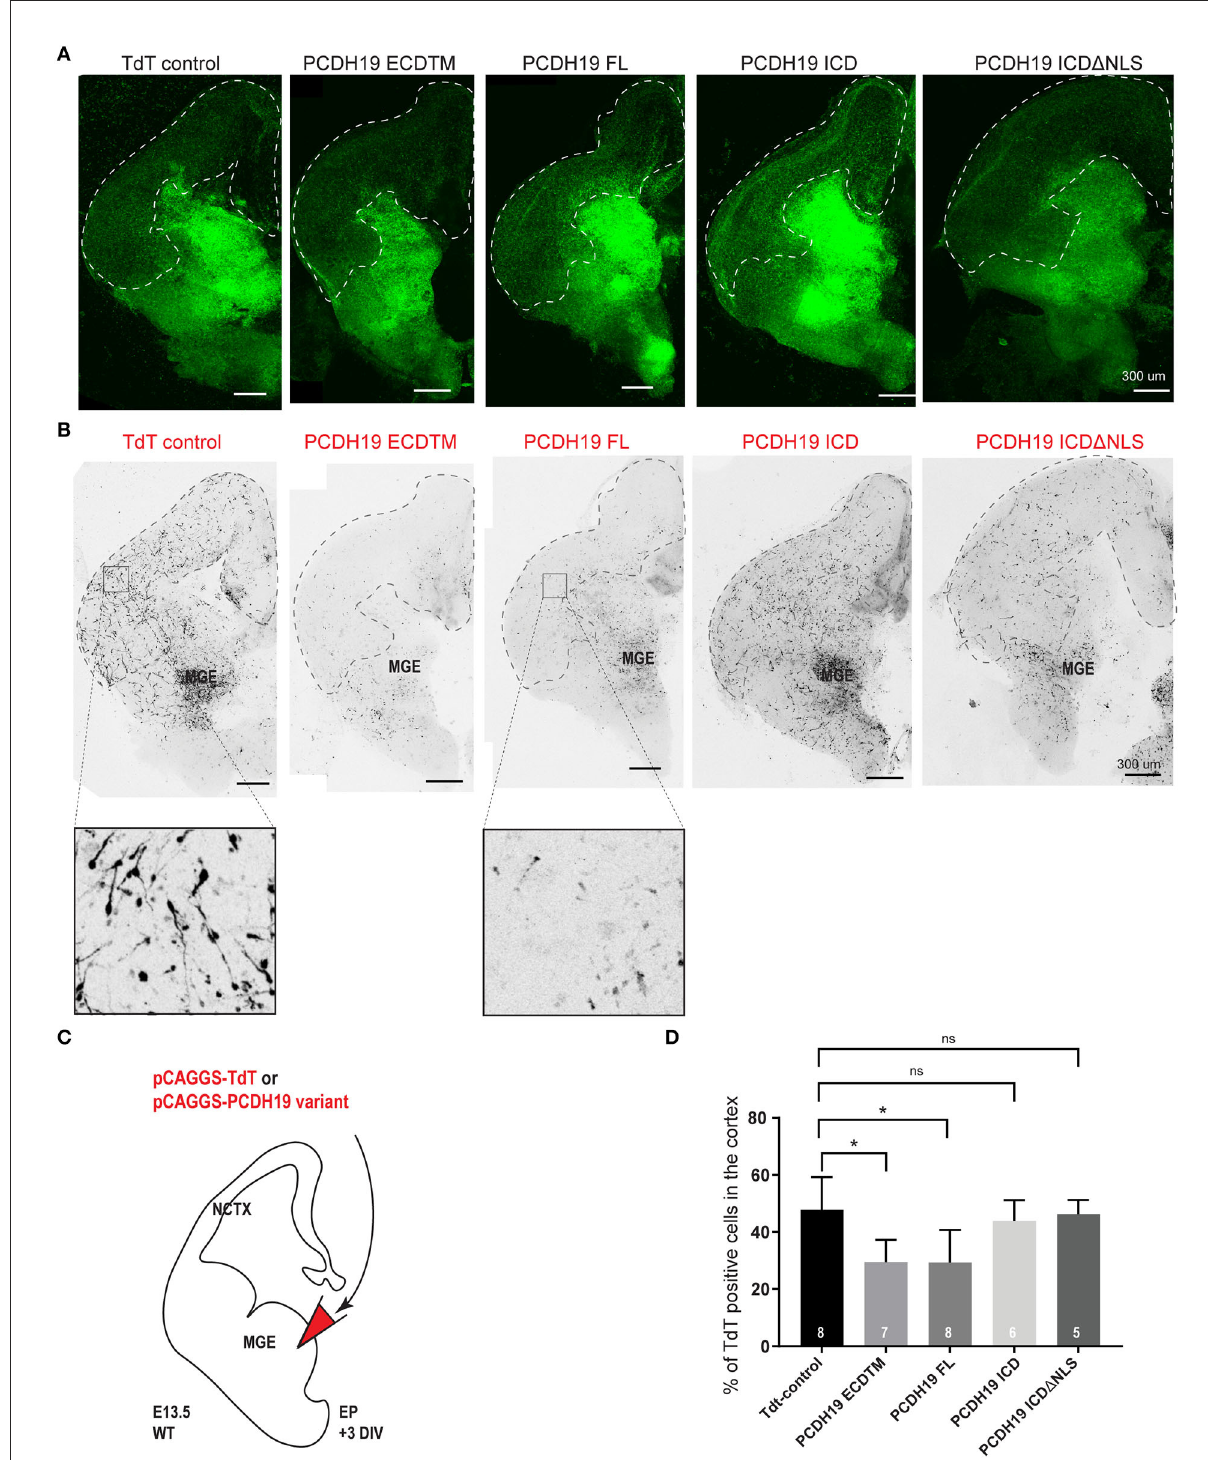
FIGURE3 PCDH19 extracellular domain misexpression significantly decreases cortical IN migration. (A) 72-h post electroporation taken Z-stack example images of brain slices of TdT control and various PCDH19 overexpression constructs for the Dlx5/6-CRE-IRES-eGFP fluorescence, including the dotted line marking the cortical field. (B) Z-stack example images of the brain slices shown in A of TdT control and diverse PCDH19 overexpression constructs for the electroporated neurons (Tomato fluorescence); the dotted line shows the cortical field. (C) A schematic of